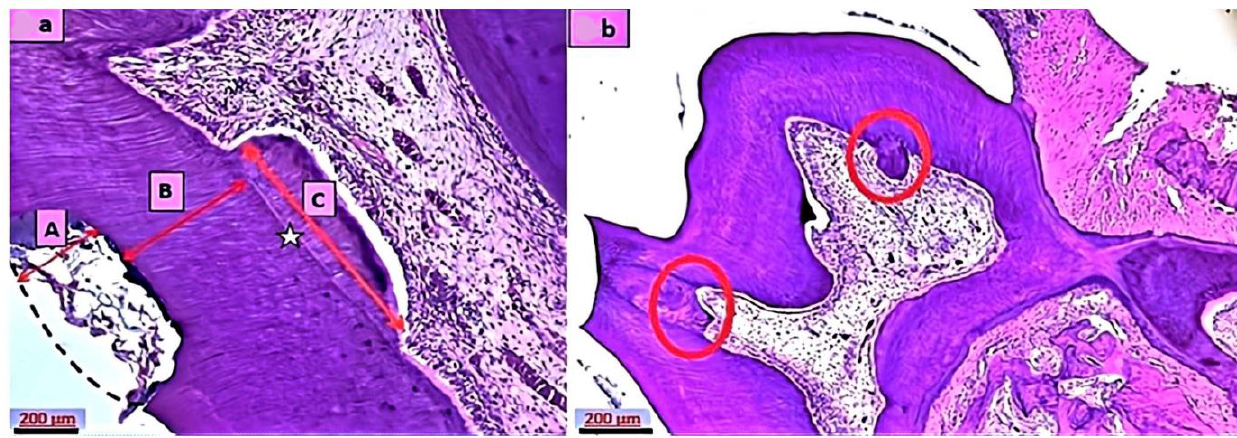
Figure 2. ( a ): (A) Restoration. (B) Remaining dentin thickness (RDT). (C) Tertiary dentin, star indicates calcio-traumatic line (H&E, 10×). ( b ): An example of the 2nd molar having some tertiary dentin formation in the occlusal (left circle) and cervical (right circle) area (H&E).